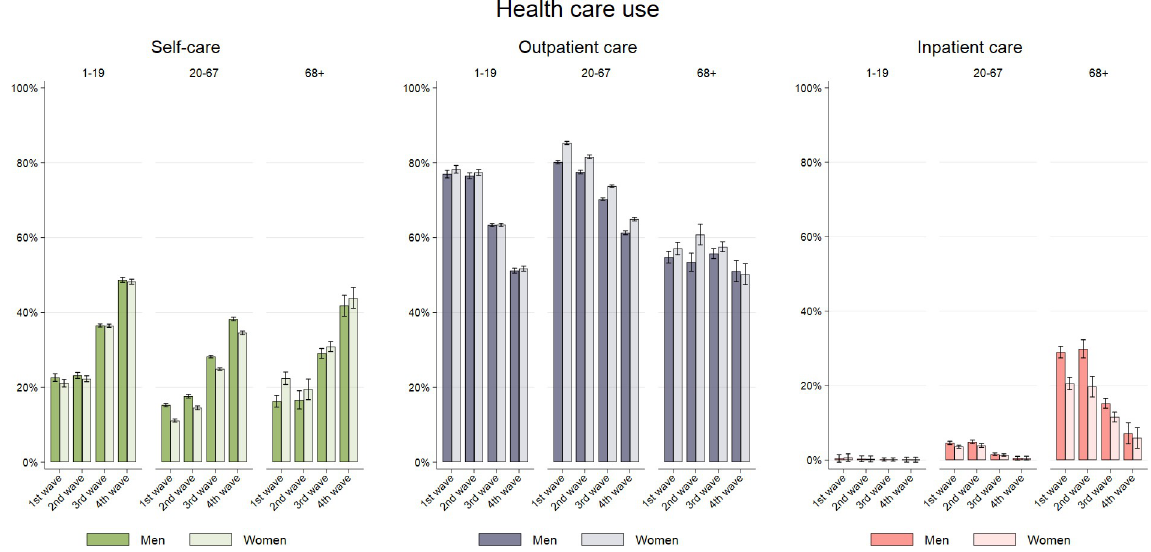
Fig 6. Health care use. Health care use during the first 30 days after a positive PCR-test for SARS-CoV-2 by age groups and gender, for four waves/periods of the pandemic: February 26 th , 2020 –February 16 th , 2021 (1 st period), February 17 th , 2021 –July 10 th , 2021 (2 nd period),